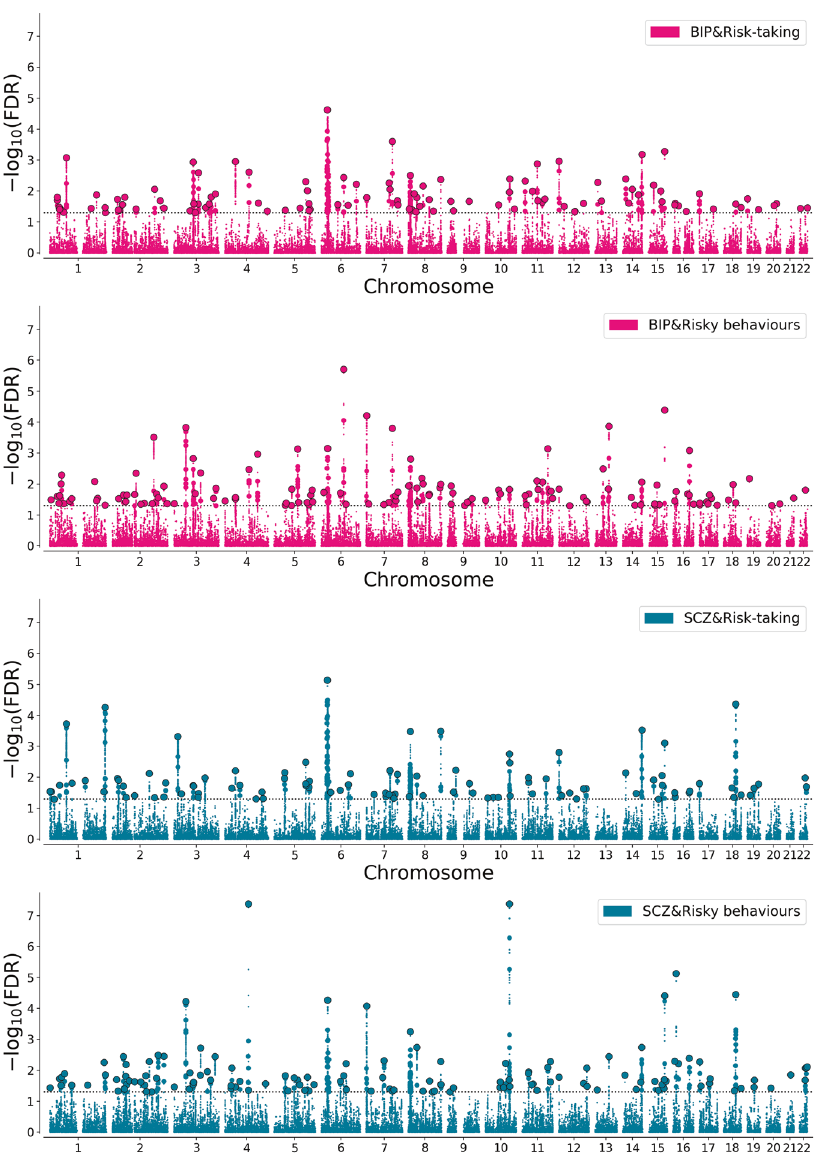
Fig. 3 Discovery of genetic loci jointly associated with risk phenotypes, bipolar disorder and schizophrenia. Manhattan plots showing the − log10 transformed conjFDR values for A bipolar disorder (BIP) and risk-taking, B BIP and risky behaviours, C schizophrenia (SCZ) and risk- taking and D SCZ and risky behaviours risk for each SNP (y-axis) against chromosomal position (x-axis). The dotted line represents the threshold for signi fi cant association (conjFDR < 0.05). Black circles represent lead